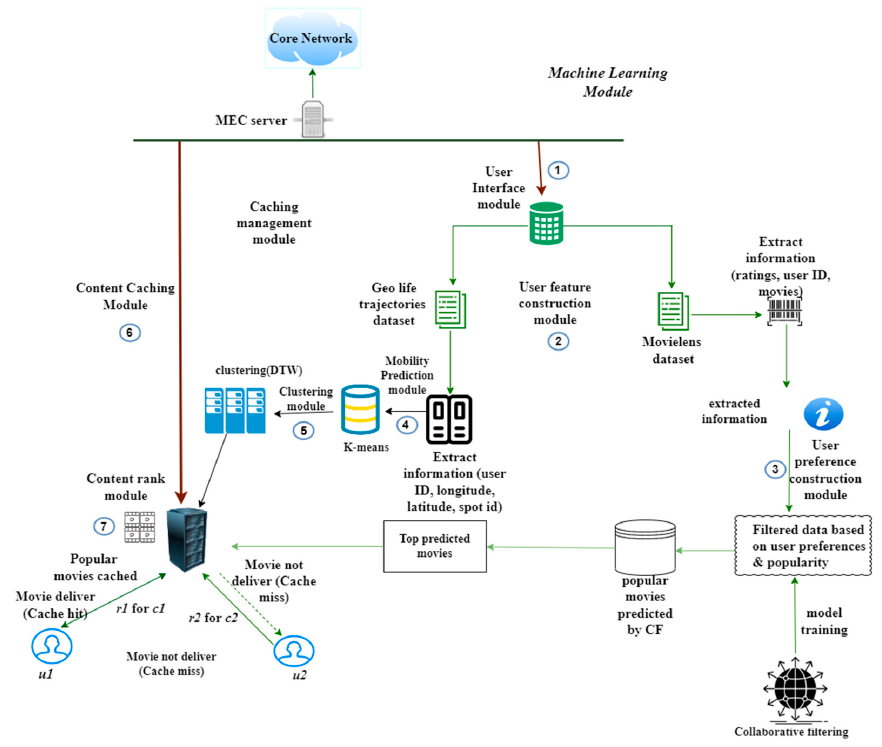
Figure 3. Modular workflow of the MUPAC framework. Algorithm 1: Content Caching Algorithm